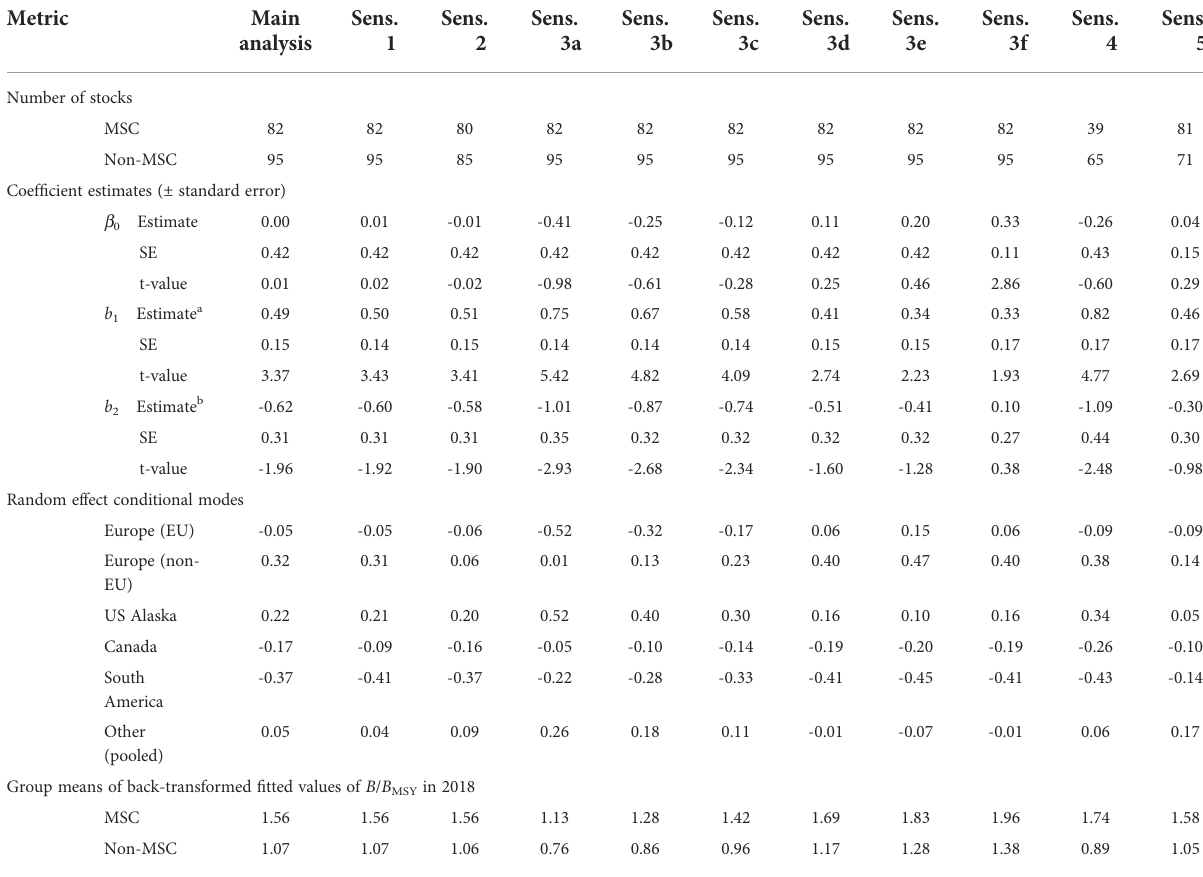
TABLE 4 Generalized linear mixed-effect model results from main analysis and sensitivity analyses for portion 3 of the analysis, comparing B / B MSY in 2018 between MSC stocks and non-MSC stocks.